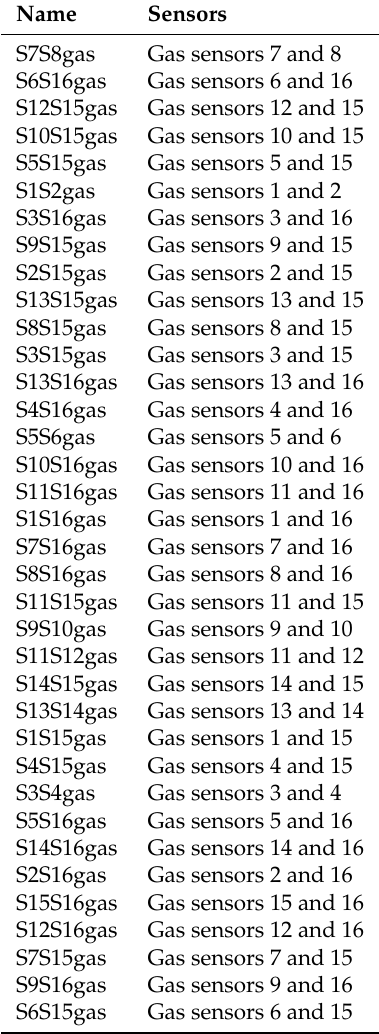
Table 5. Data sets obtained from gas sensor pairs from GSAD data set for month 36.